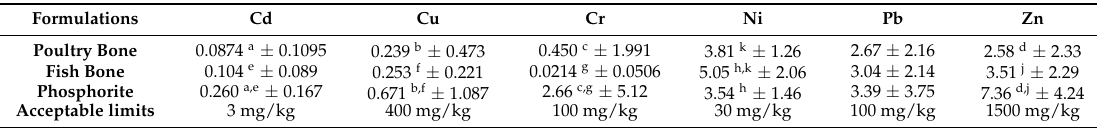
Table 4. The content of toxic elements present in the obtained formations (mg/kg) ( N = 10), mean ± SD, and acceptable limits of their content in the fertilizers pursuant to the Regulation of the Minister of Agriculture and Rural Development of Poland on the Implementation of Certain Provisions of the Act on Fertilizers and Fertilization (Journal of Laws of 2004 No. 236, item 2369). a–j indicate statistically significant differences at p < 0.05.